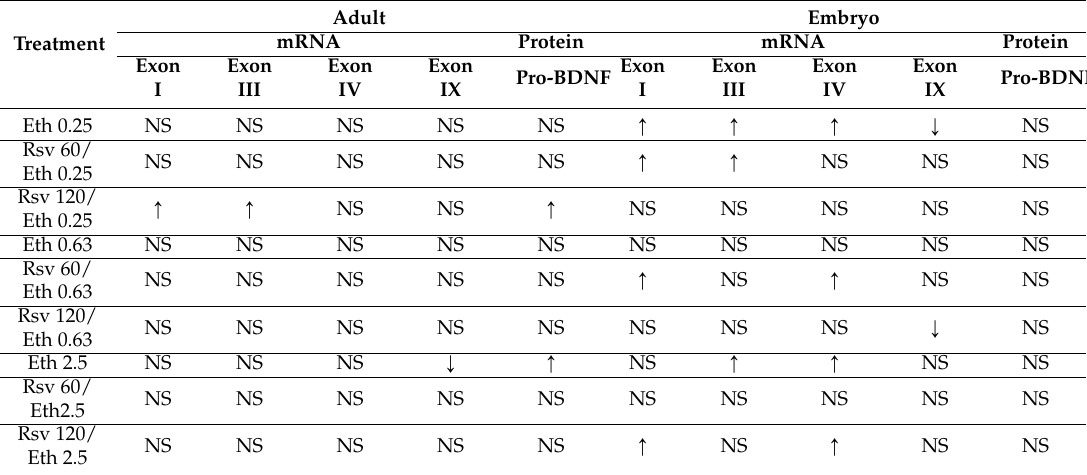
Table 2. Effect of three Eth doses alone or in combination with Rsv (60 and/or 120 mg/kg ¨ BW/day) on BDNF mRNA and protein levels in the hippocampus of adult and embryonic rats.